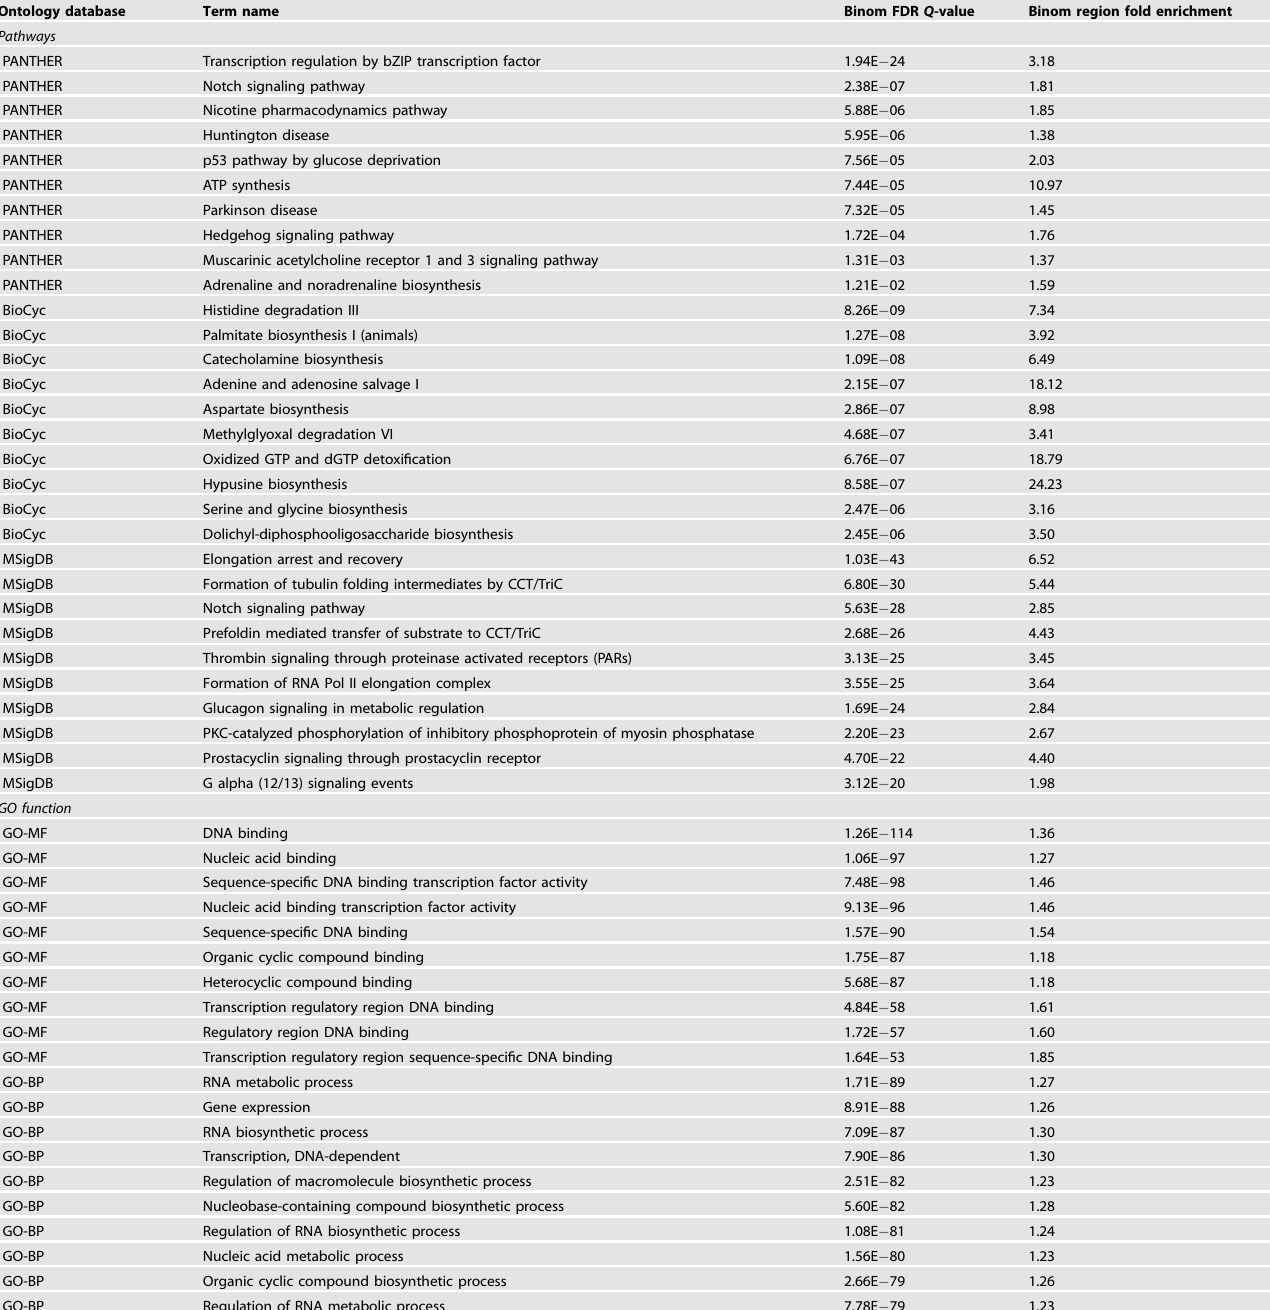
Table 3. The top GREAT ontology enrichments for regions potentially related to depression by using binomial test. Ontology